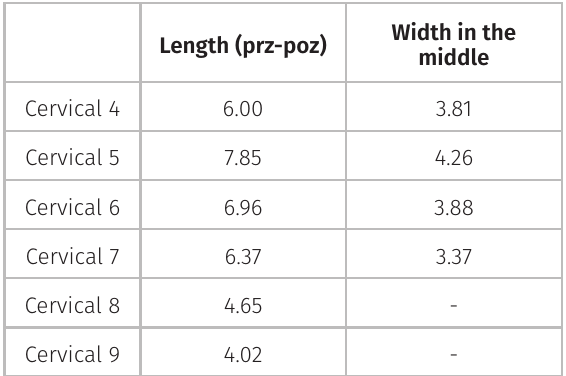
Table II. Measurements of cervical vertebrae in Kunpengopterus sinensis (STM 19-59) (in